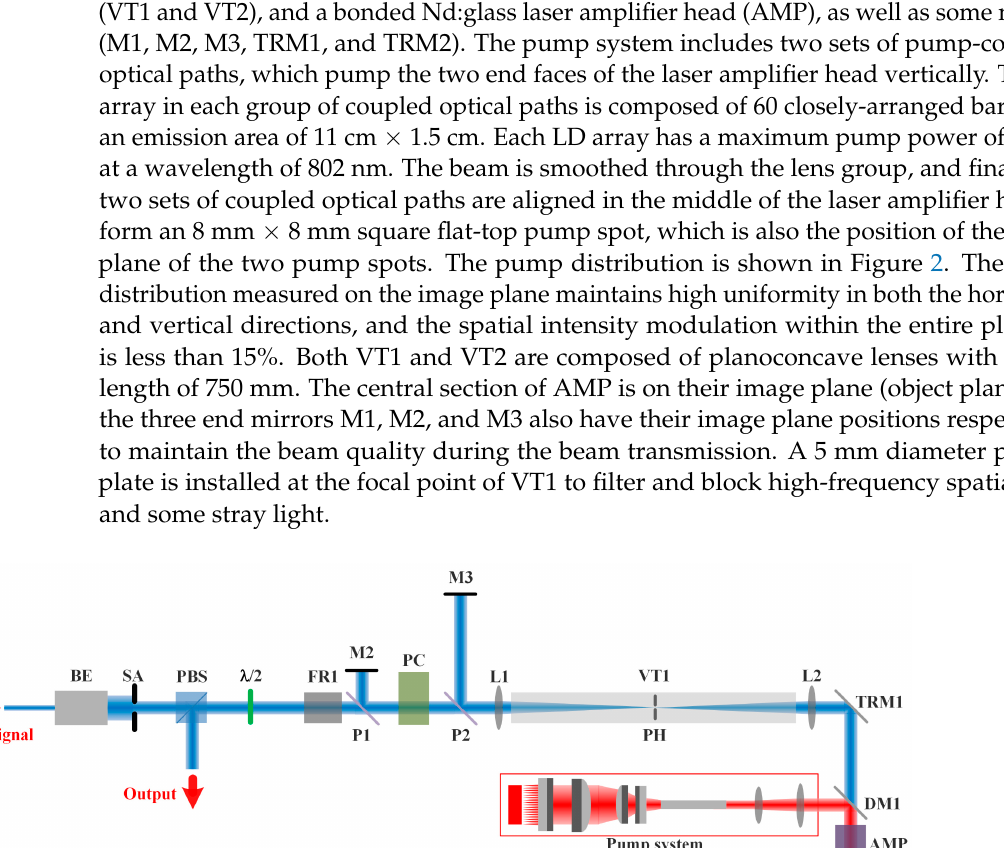
Figure 2. Pump light distribution.